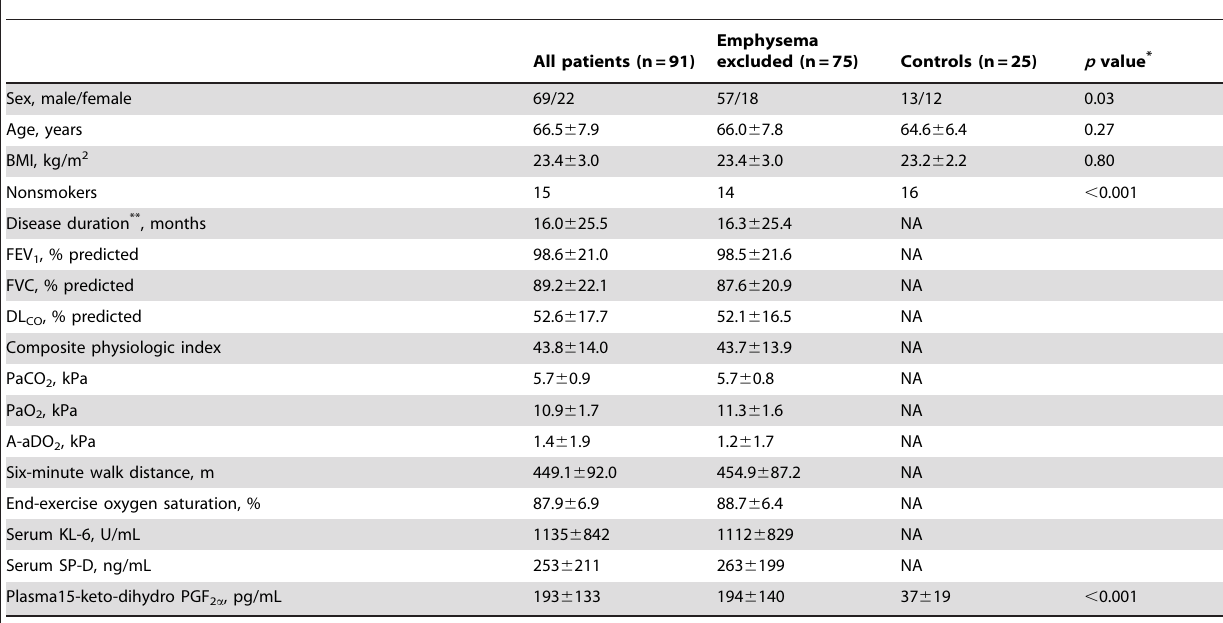
Data are presented as mean 6 standard deviation. *Comparison between all patients and controls. **Time from diagnosis to blood sample collection. BMI, body mass index; FEV 1 , forced expiratory volume in 1 second; FVC, forced vital capacity; DL CO , diffusing capacity for carbon monoxide; PaCO 2 , arterial partial pressure of carbon dioxide;